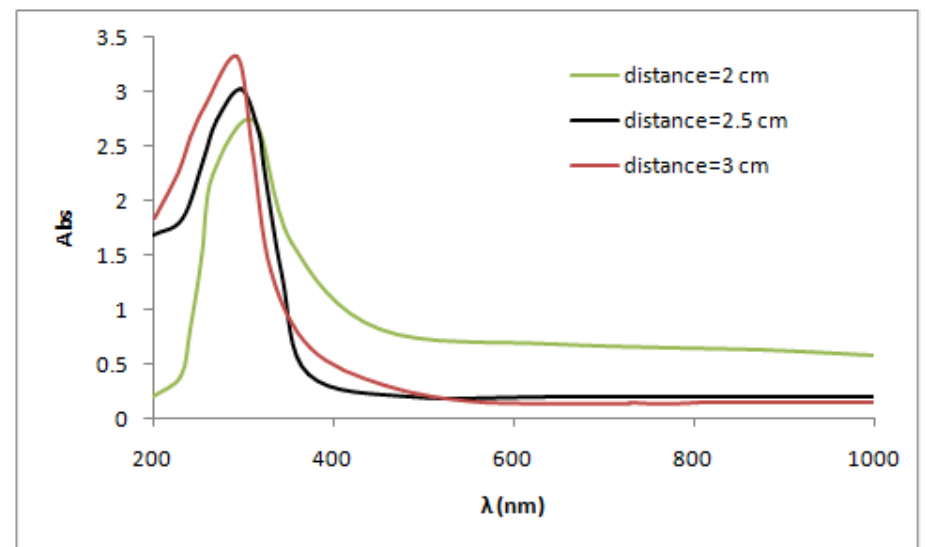
Fig. 2: Absorption spectra for a-C: H thin films thin film at the different distance between the substrate and plasma torch.